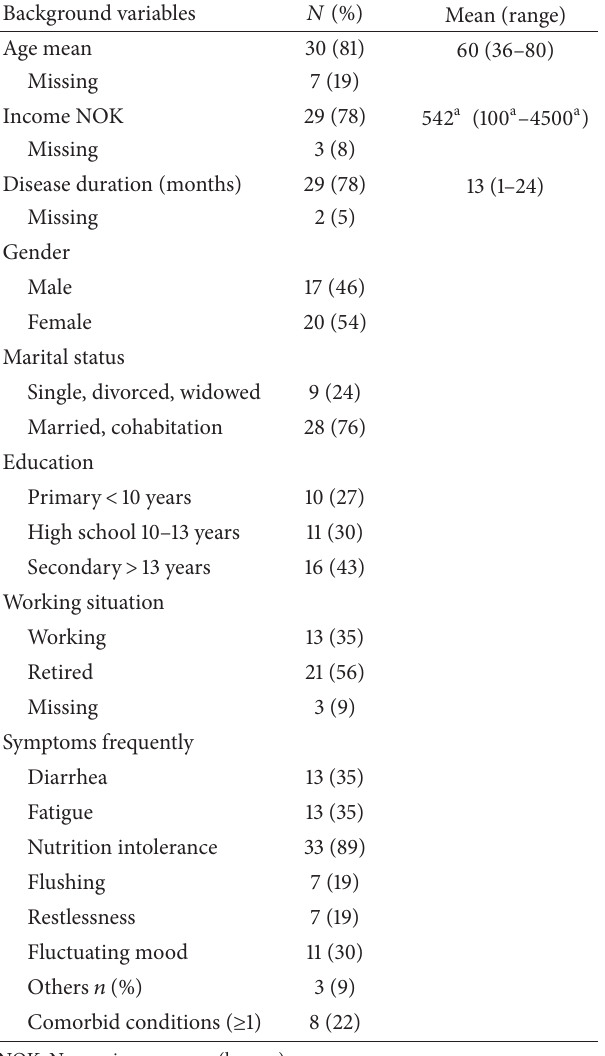
Table 2: Sample characteristics at time of inclusion ( 𝑛 =